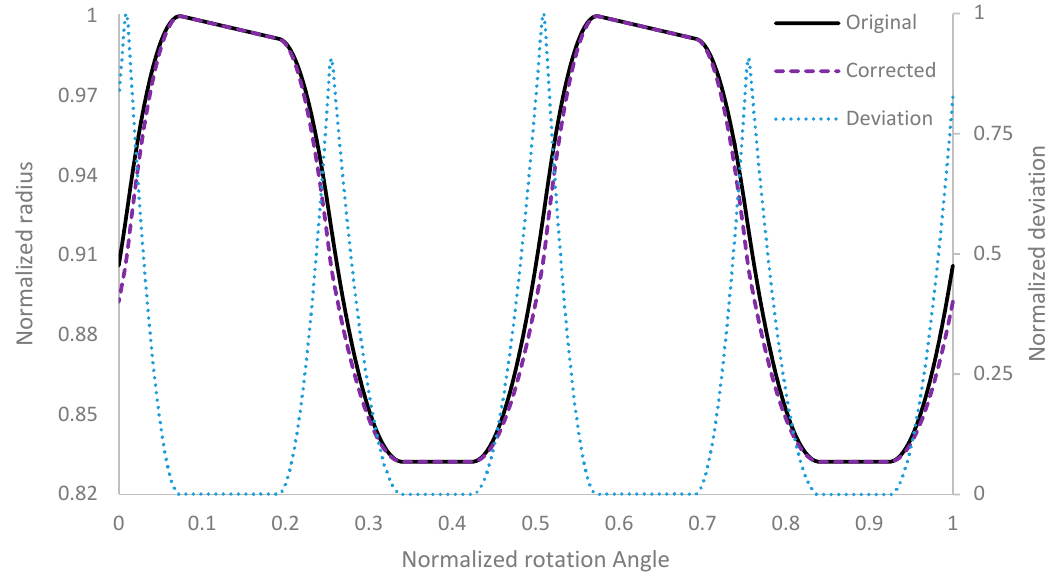
Figure 5. Normalized original radius of the cam ring, normalized corrected contact curve radius (left axis), normalized deviation between cam ring and contact curve (right axis).